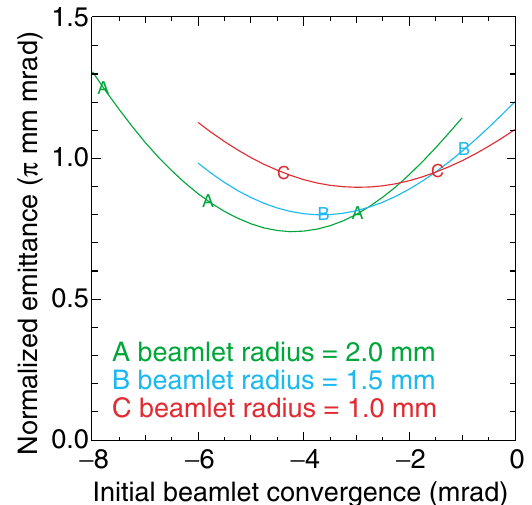
FIG. 9. (Color) Emittance versus convergence angle for various values of current, for the same number of beamlets, merging at 1.2 MeV. The upper curve in each pair is with beamlet radii of 1 mm, and the lower is with 1.5